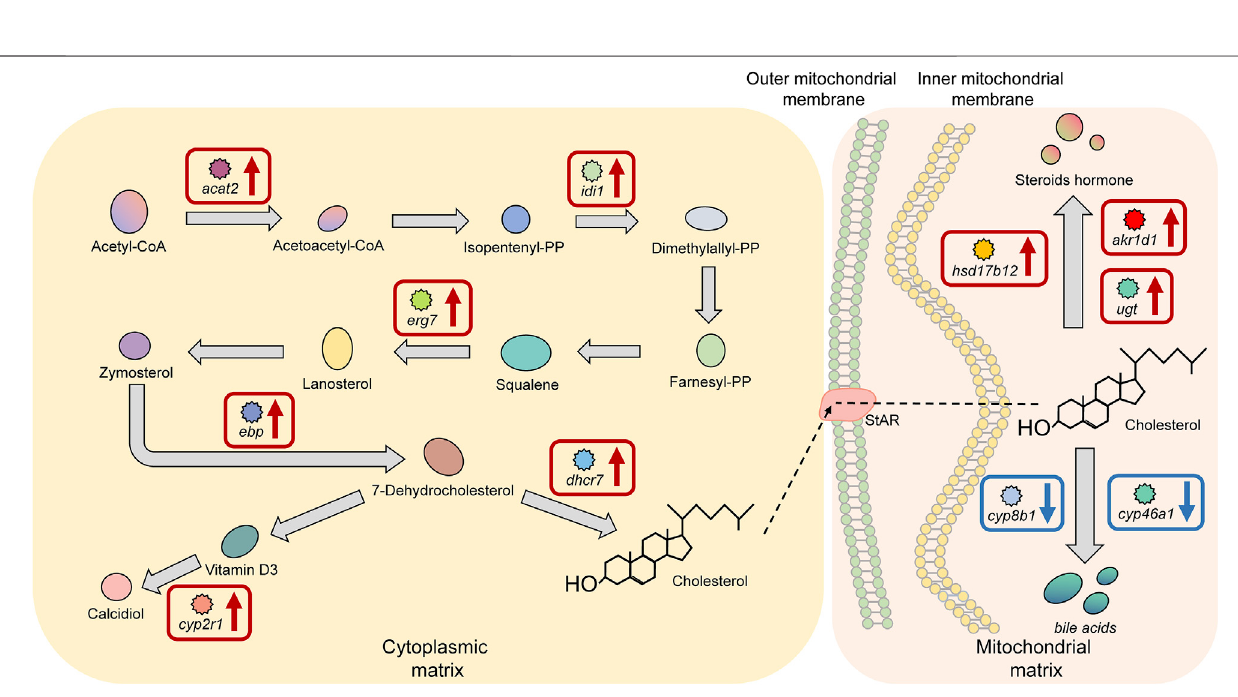
Frontiers in Genetics |